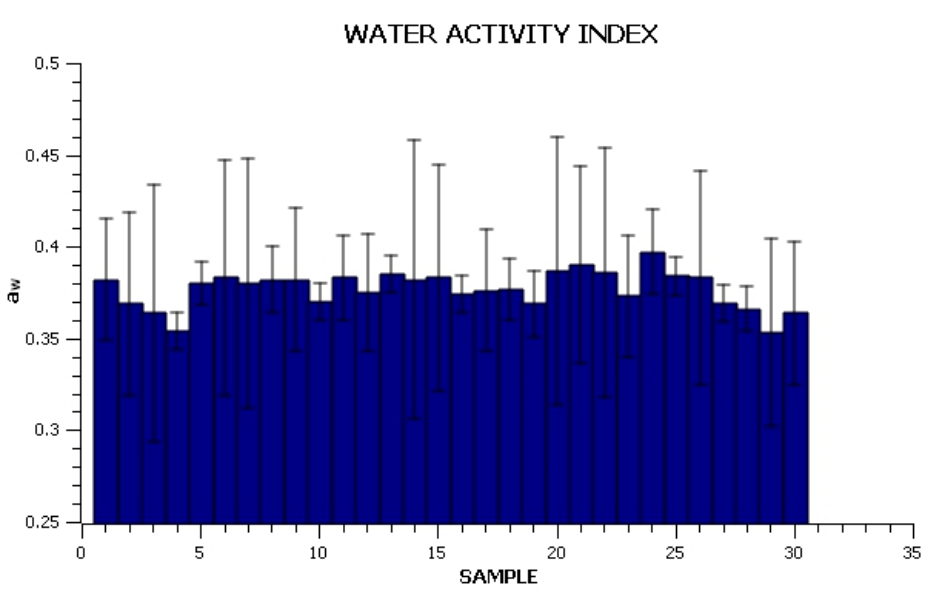
Figure 6. Water activity index of tested films